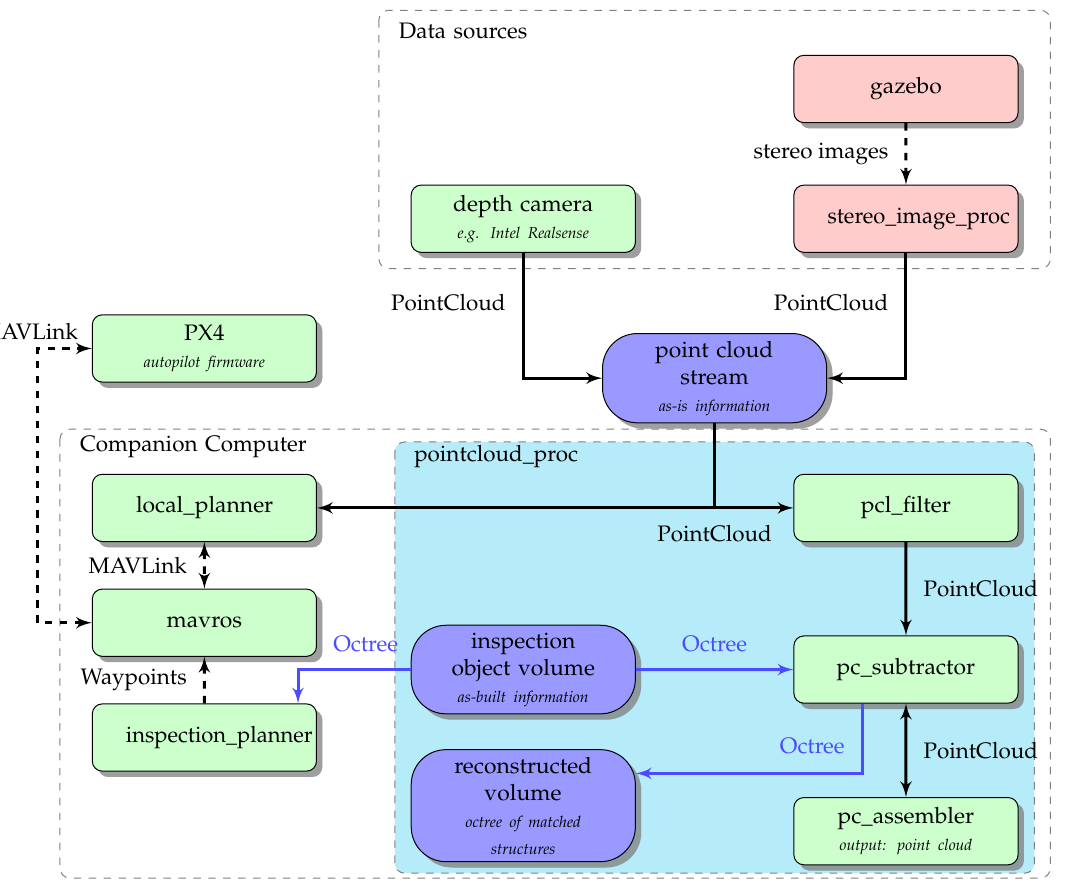
Figure 2. The component architecture of the proposed toolchain. Green nodes represent individual software modules, red nodes indicate simulation components and data artefacts are represented by blue nodes. Solid black arrows represent point cloud data, blue arrows represent access on octrees, any other data is represented by dashed